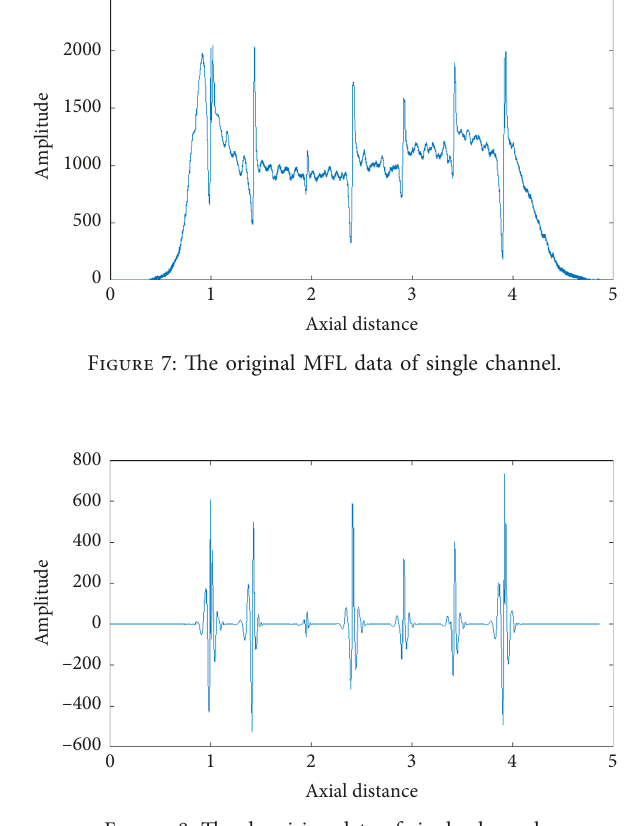
Figure 8: The denoising data of single